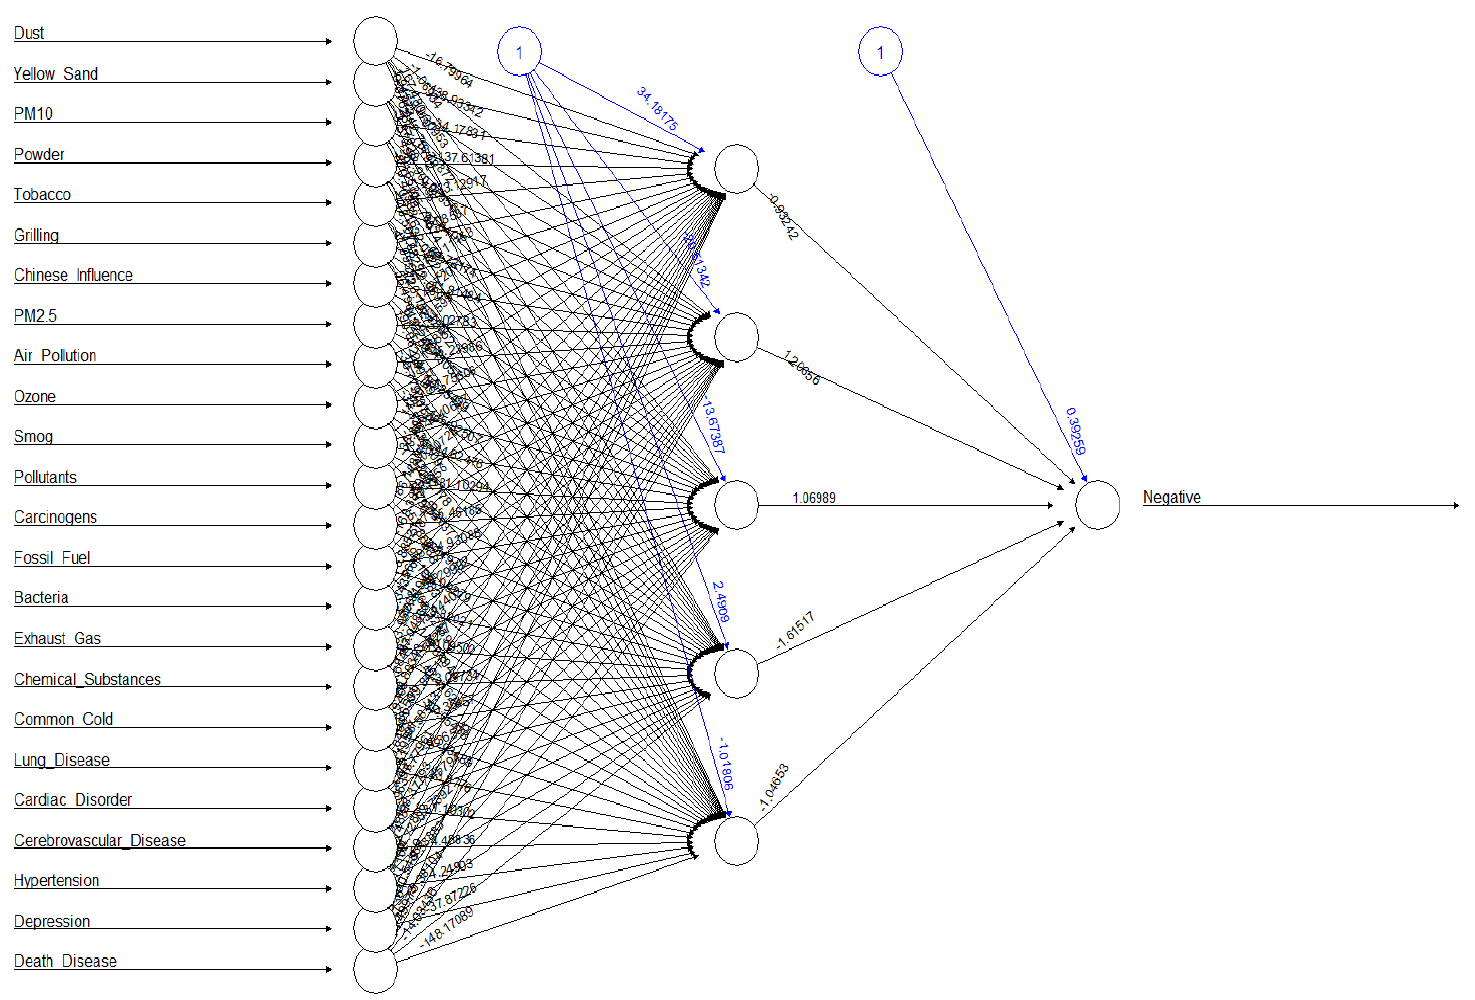
Figure 4. Particulate-Matter Cause-and-Disease Risk Multilayer Neural Network Prediction Model.